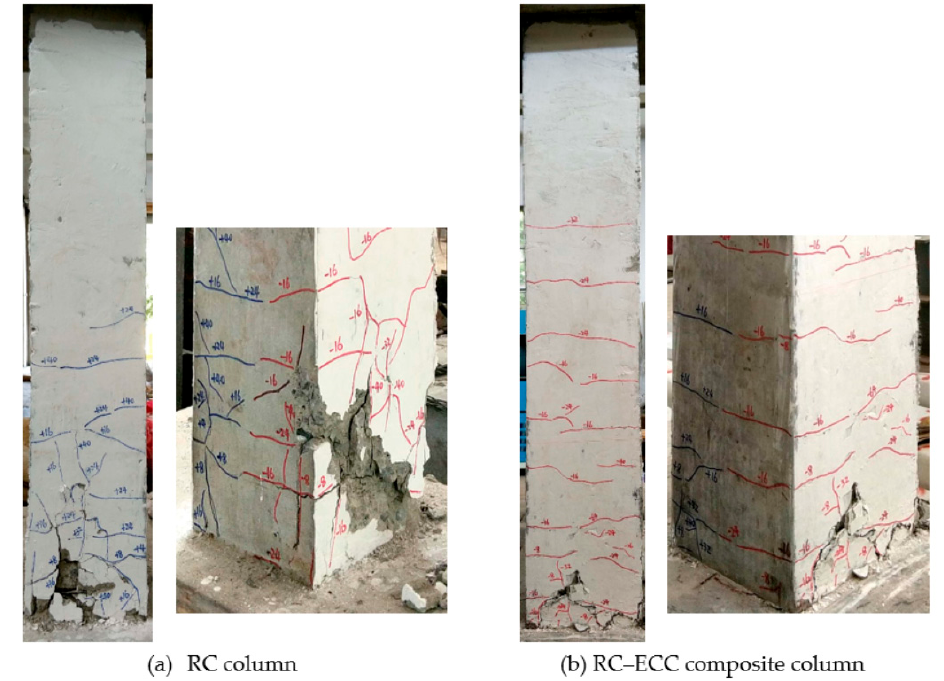
Figure 6. Failure modes and crack patterns of specimens.